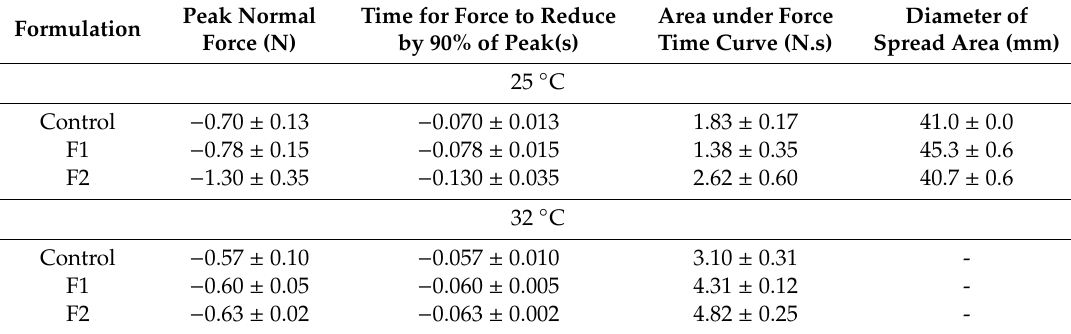
Table 2. Adhesive properties at 25 ◦ C and 32 ◦ C (mean ± SD, n = 6) and spreadability properties of the formulations (mean ± SD, n =